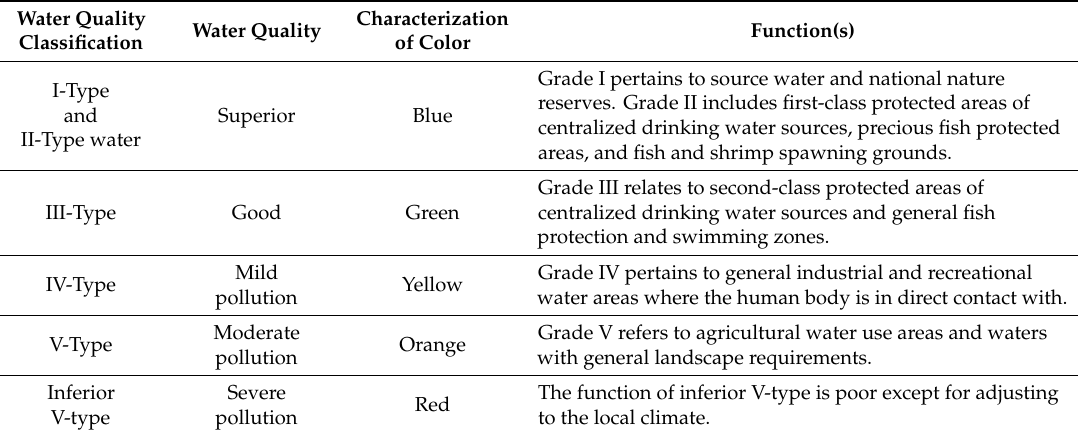
Table A1. The quality standard for surface